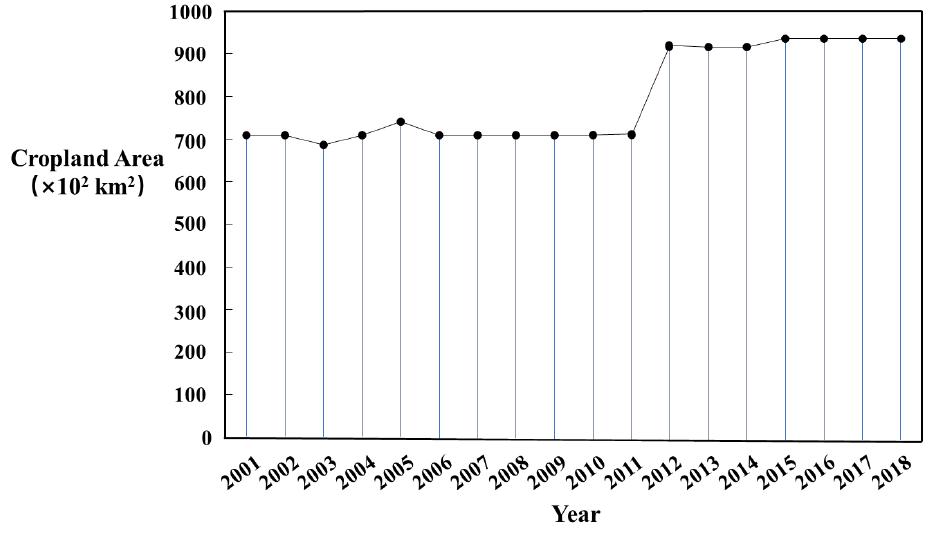
Figure 4. Changes in cropland area from 2001 to 2018 in the Inner Mongolia Autonomous Region.